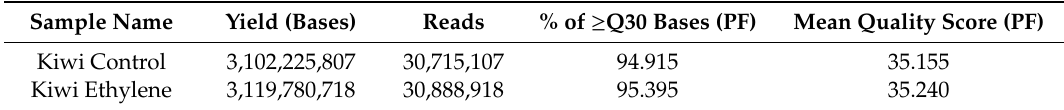
Table 2. Summary of the sequencing result.